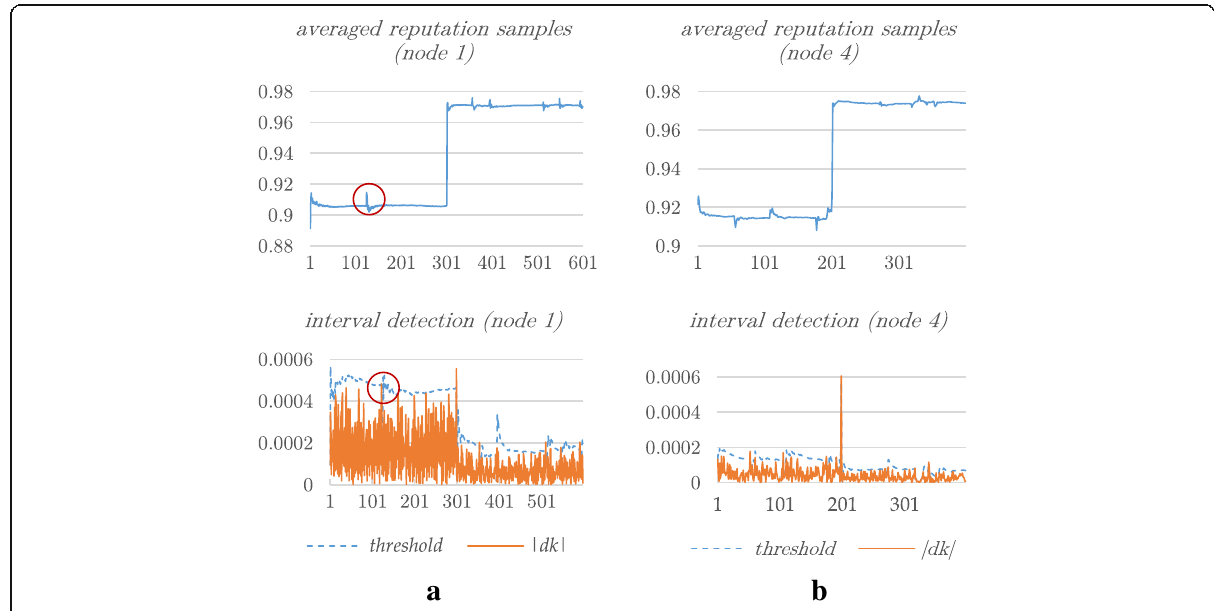
Fig. 4 Average value of the samples (figures at the top) and interval detection (figures below) when β =0.01 and F =2: a for node 1 and b for node 4